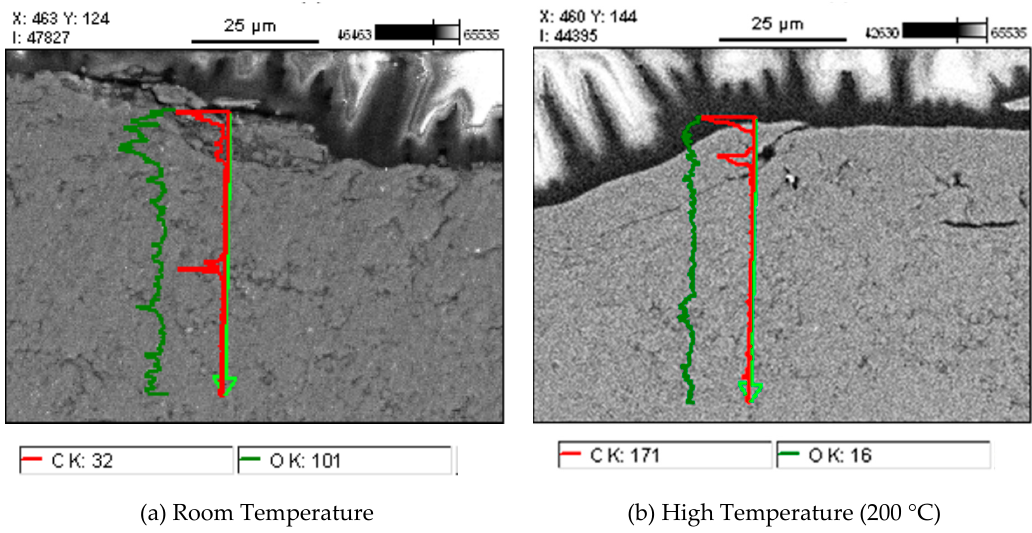
Figure 12. Cross sectional SEM image and Energy Dispersive Spectroscopy (EDS) analysis showing carbon and oxygen distribution below the wear track of Al-2 vol % GNP sample: ( a ) RT and ( b ) 200 °C.